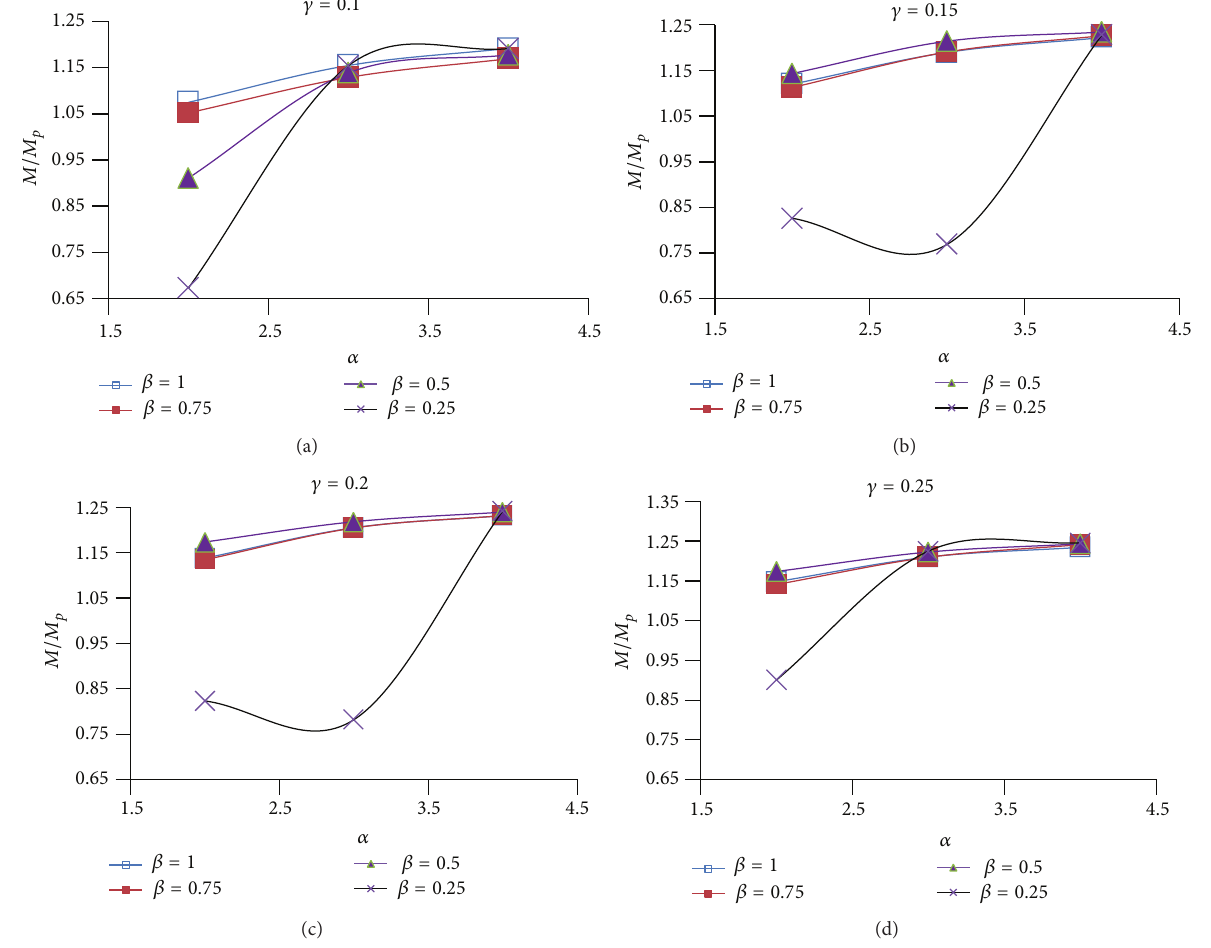
Figure 13: 𝑀/𝑀 𝑃 versus 𝛼 for different values of 𝛽 and 𝛾 for